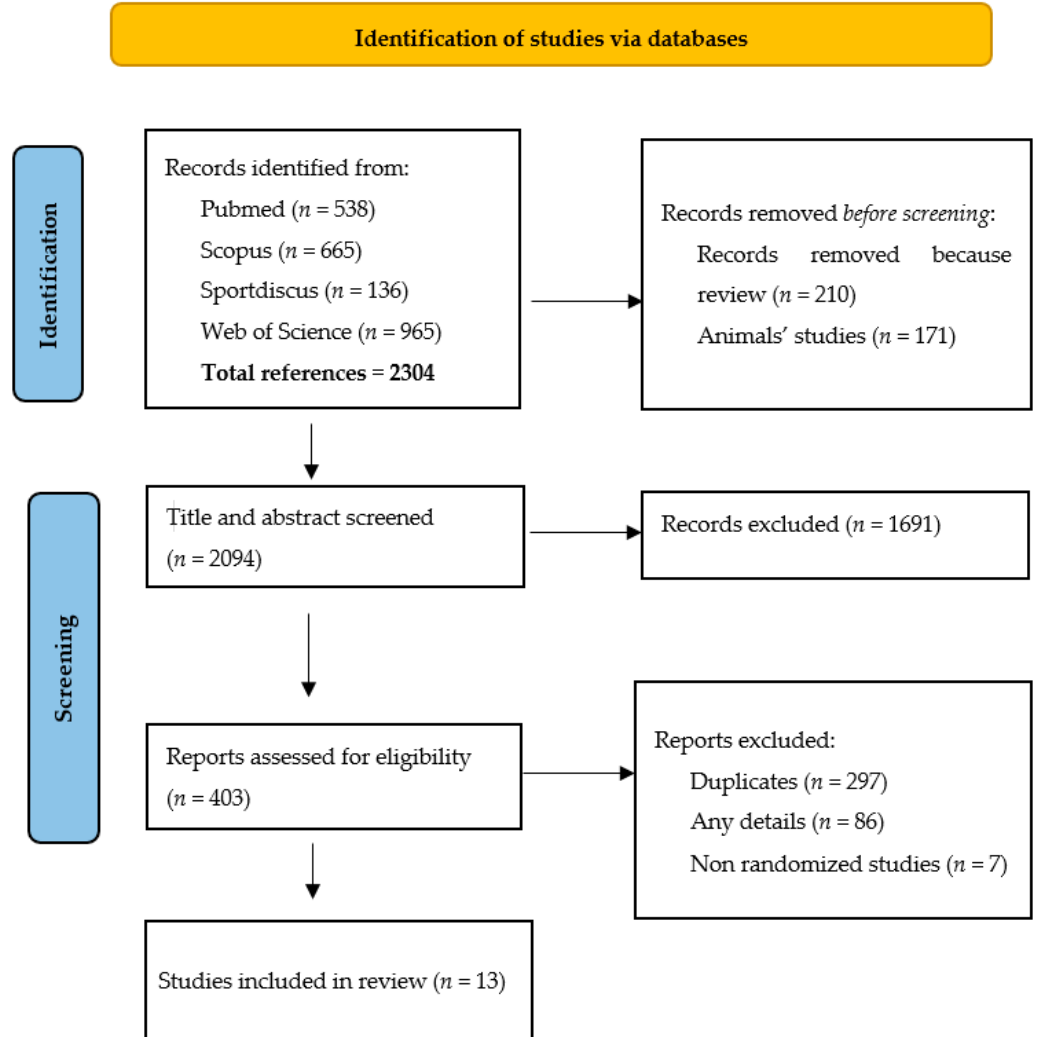
Figure 1. Prisma flow diagram of the article selection.